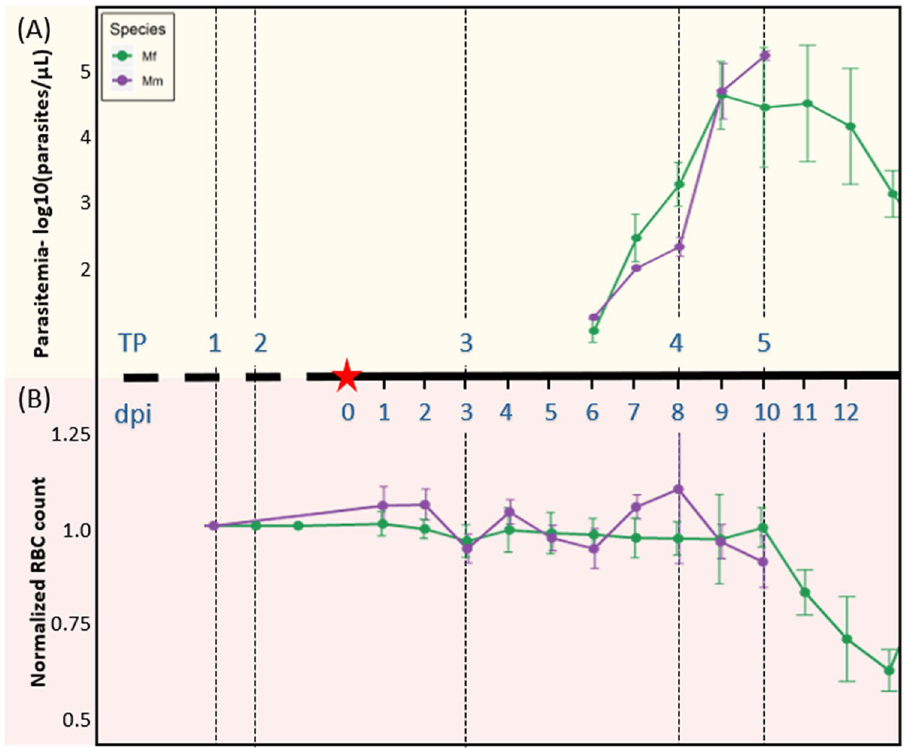
Figure 1. Timeline of Mm and Mf infection with P. knowlesi , along with parasitemia levels and RBC counts. The x-axis depicts the time points (TPs) and days post inoculation (dpi). The red star represents the day of sporozoite inoculation (i.e . , dpi 0). Data at TP1 were collected more than a month before TP2. ( A ) Parasitemia: The y-axis shows average parasitemia levels throughout the P. knowlesi infection on a log10 scale. Parasitemia levels were measured as parasites/μL. ( B ) Normalized RBC counts: The y-axis shows the ratio of mean RBC counts with respect to pre-infection levels